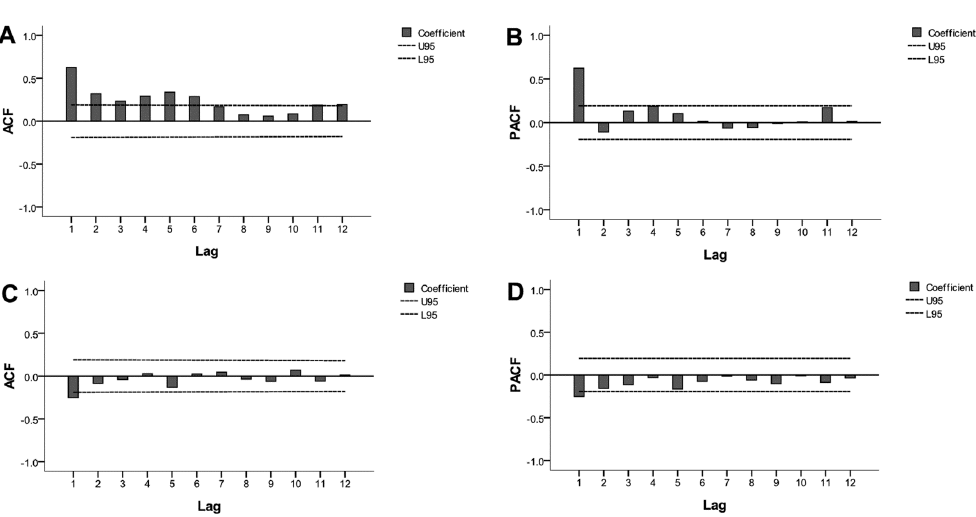
Figure 4. Autocorrelation function (ACF) and partial autocorrelation function (PACF) plotted against time lags for the original series ( A , B , respectively) and after one order of regular differencing and one order of seasonal differencing ( C , D , respectively). Dotted lines indicate the 95% confidence intervals (CIs). Most of the correlations fall around zero within their 95% CIs (U95: upper limit of 95% CI; L95: lower limit of 95% CI) except at the first lag, which indicates the series would achieve stationarity. Finally, the ARIMA model (1, 1, 1) (1, 1, 0) 12 was used to forecast ILI% from January to December 2015. The fitting and forecasting results are shown in Figure 5. Compared with the actual values in 2015, the results of prediction were fitted well, indicating that the ARIMA model was effective.